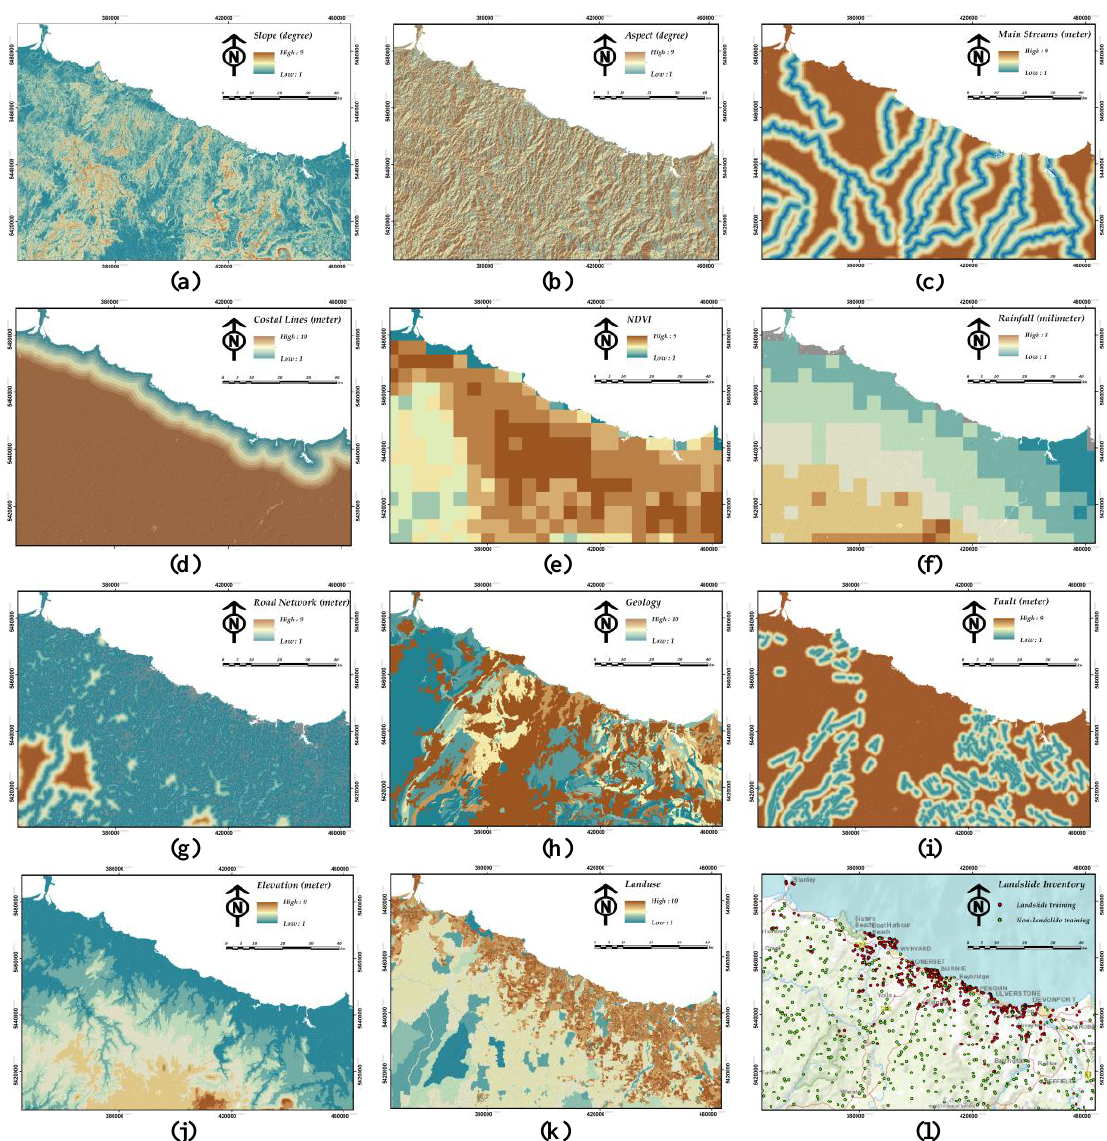
Figure 2. Eleven applied landslide-conditioning factors involving: ( a ) Slope; ( b ) aspect; ( c ) distance to main streams; ( d ) distance to coastal lines; ( e ) NDVI; ( f ) mean annual rainfall; ( g ) distance to roads; ( h ) geology; ( i ) distance to faults; ( j ) elevation; ( k ) land-use, and ( l ) landslide / non-landslide inventory database used for training the model.